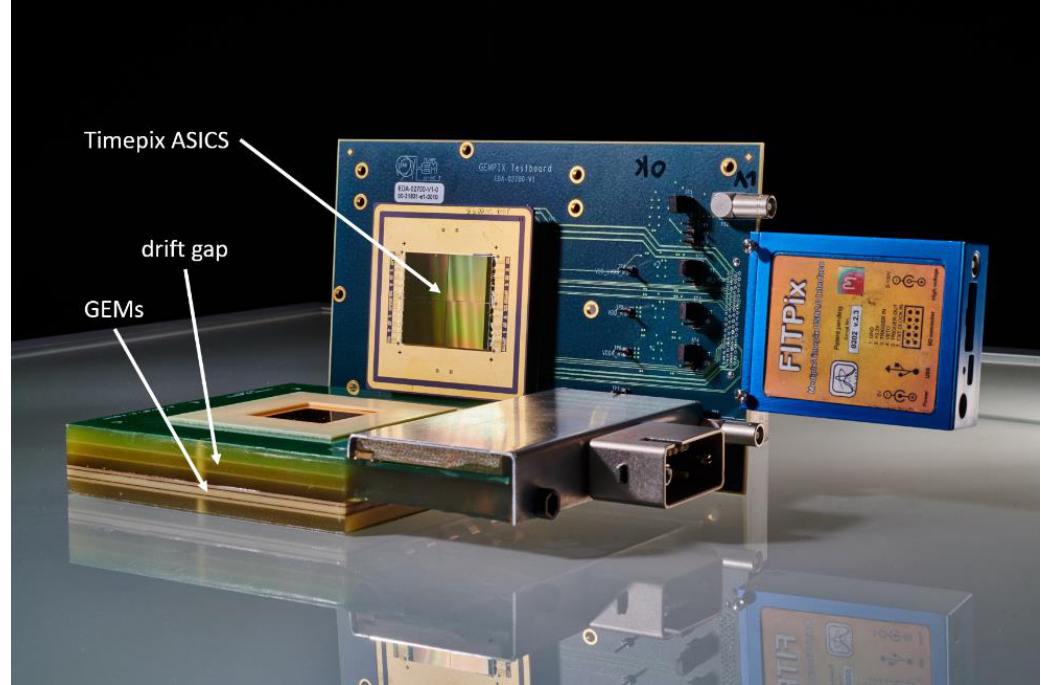
Figure 1. The open GEMPix, showing the four Timepix ASICs and the FITPix readout module. The position of the drift gap and the GEMs is labelled (source: CERN).